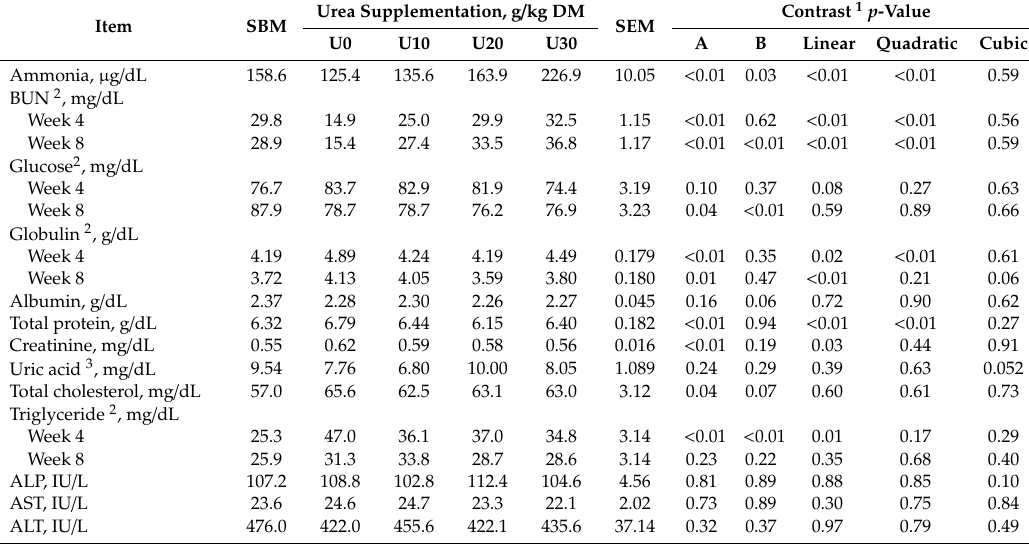
Table 4. E ff ects of urea supplementation on plasma metabolites in fattening